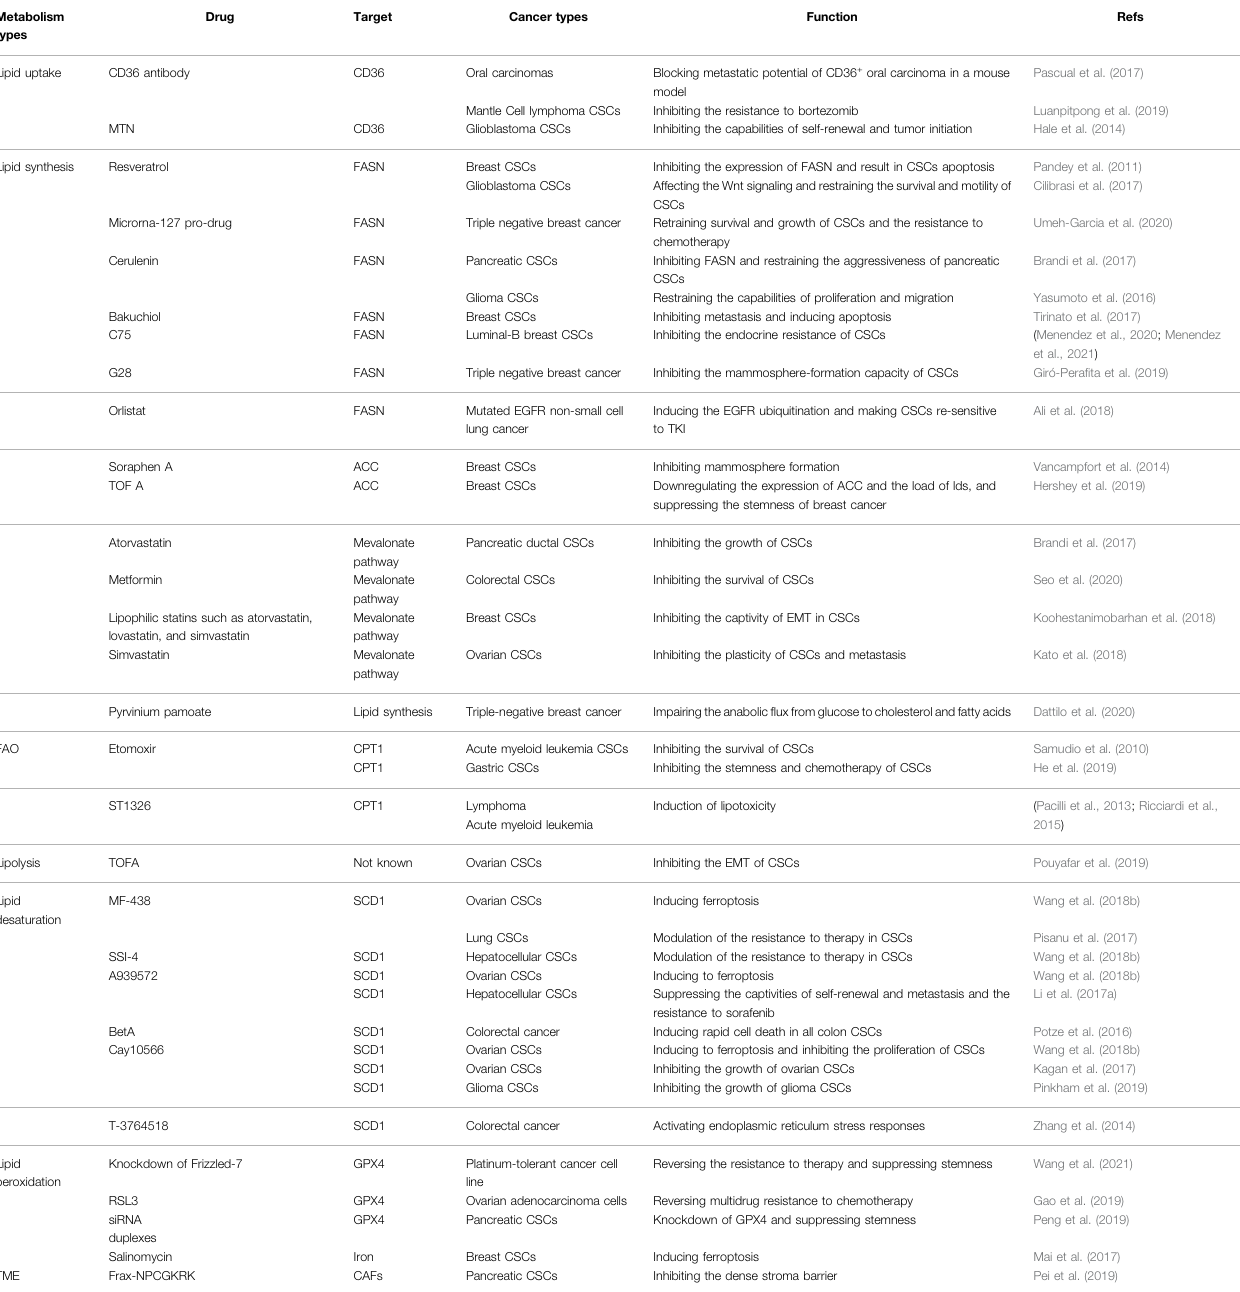
TABLE 1 | Inhibitors of lipid metabolism involved in CSCs. Metabolism